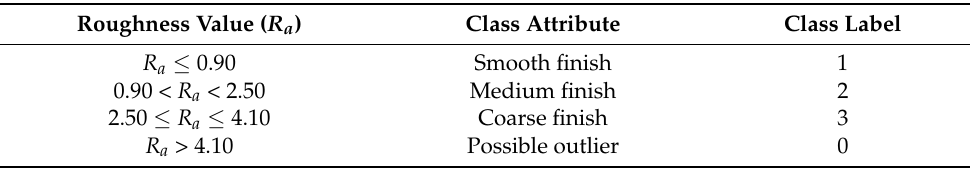
Table 1. Class labels based on roughness ( R a ) values.